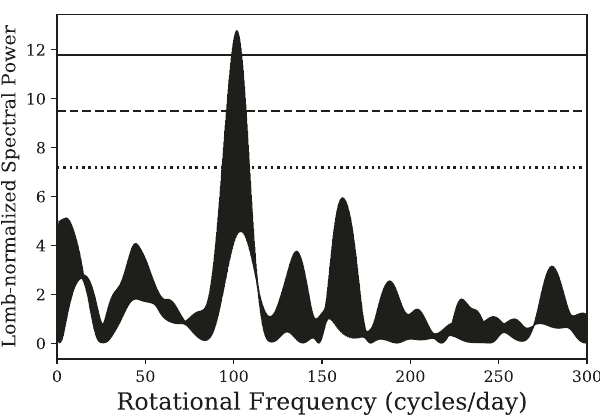
Fig. 5 Lomb-Scargle periodogram from combined LBT and LDT photometry. We fi nd that the observations are well described by a double- peaked lightcurve with asymmetric minima, corresponding to a rotational period twice that of the single-peaked solution shown in the periodogram. Dotted, dashed, and solid lines plotted on the periodogram indicate con fi dence intervals of 99.9%, 99.0%, and 90.0%, respectively.